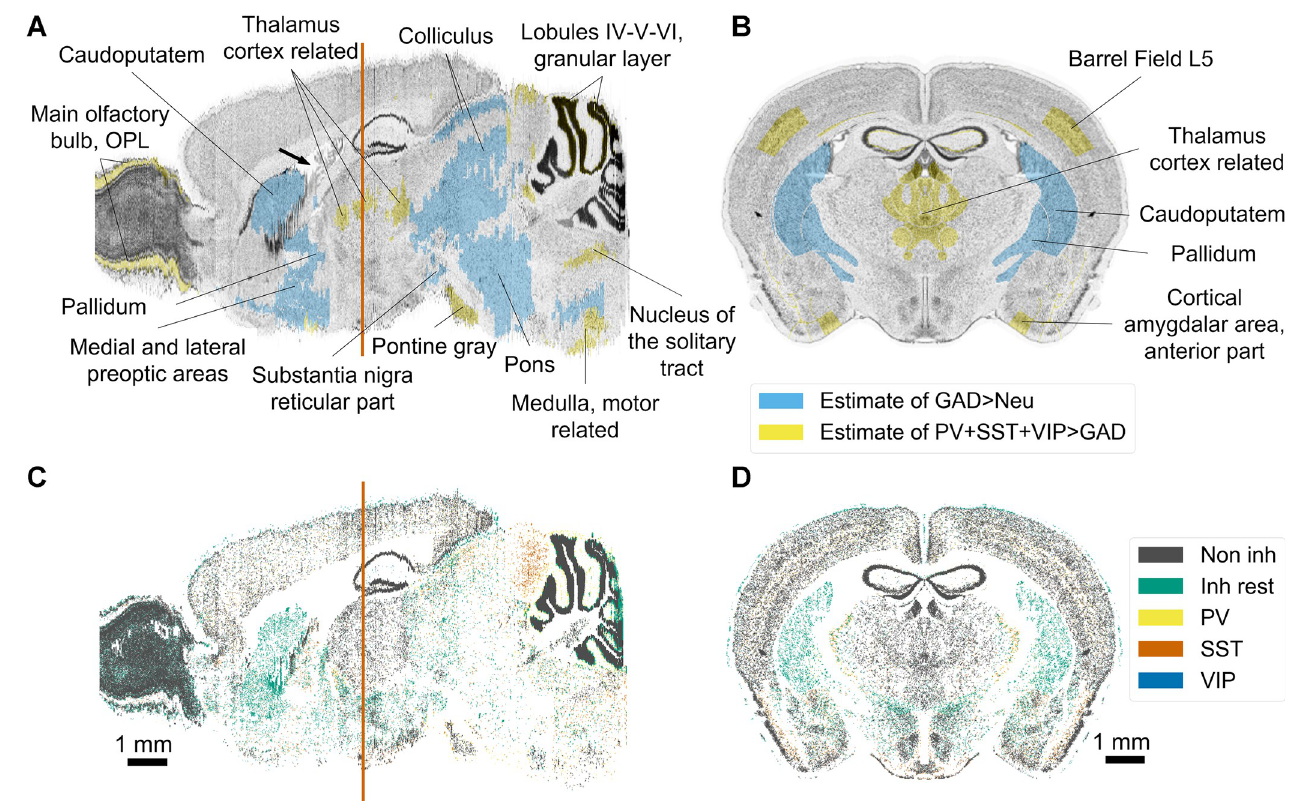
Fig 6. Results of the density pipeline. (A) Sagittal and (B) coronal view of the Nissl reference atlas used for BBCAv2, showing cells of the mouse brain. Regions with high cell density appear in dark grey. Regions that required significant corrections (see Section 2.7) for their neuron subtype density estimates are colorized (Neu = neuron). The coronal slice chosen is displayed as an orange line on the sagittal slices. Arrow in black shows the location of the lateral ventricle of the mouse brain. The blue line behind the sagittal slice highlights the drop of Nissl expression coming from the original Nissl experiment from Dong [18]. (C). Sagittal and (D). coronal view of the BBCAv2, showing the positions of the different types of neurons. PV+, SST+ and VIP+ cells appear respectively in yellow, dark orange and blue. The rest of the GABAergic population is color-coded in green and the remaining neurons in gray. The variation of the distribution of neurons is following the original distribution of Nissl